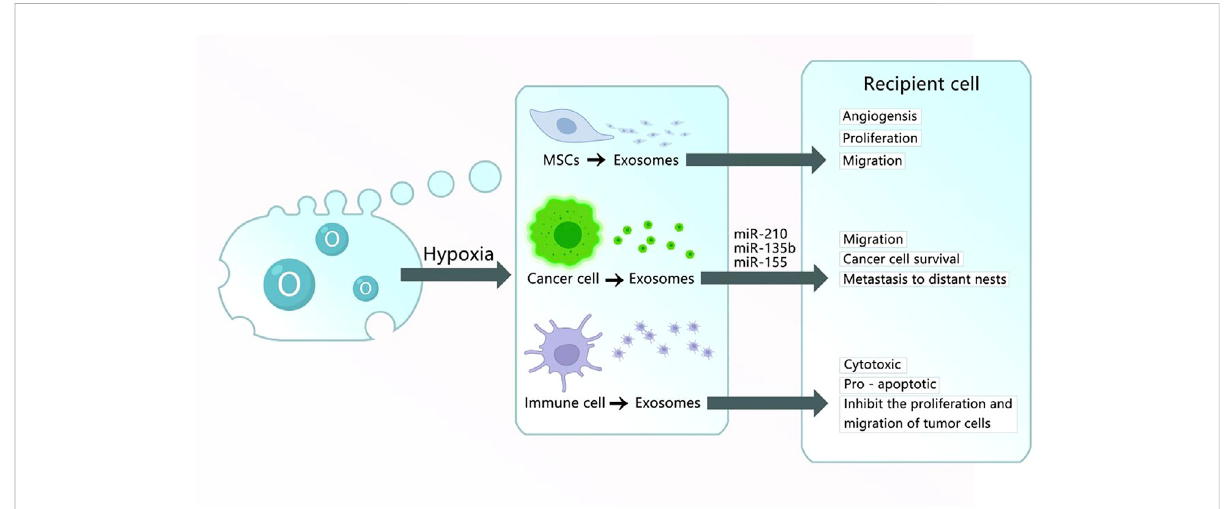
FIGURE 3 Exosomes obtained under hypoxic culture. (1) Exosomes derived from MSC cultured in hypoxic conditions carry HIF-1 α , VEGF-A, EGFR, and other materials into the recipient cell to promote the angiogenesis, proliferation, and migration of damaged tissues. (2) Exosomes derived from cancer cells cultured in hypoxic conditions carry miR-210, miR-135b, miR-155, and other RNA or proteins into recipient cells to promote angiogenesis, migration, cancer cell survival, and metastasis to distant nests. (3) Exosomes derived from immune cells cultured in hypoxic conditions have cytotoxic and pro-apoptotic effects and inhibit the proliferation and migration of tumor cells.